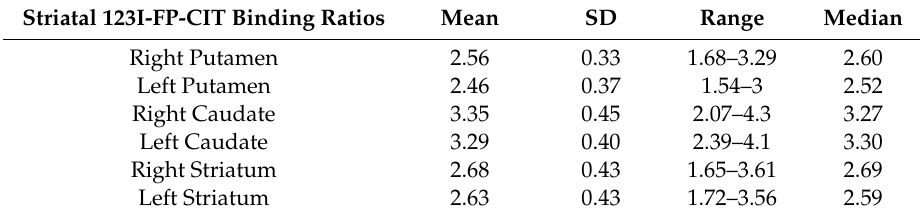
Table 2. DAT striatal availability.